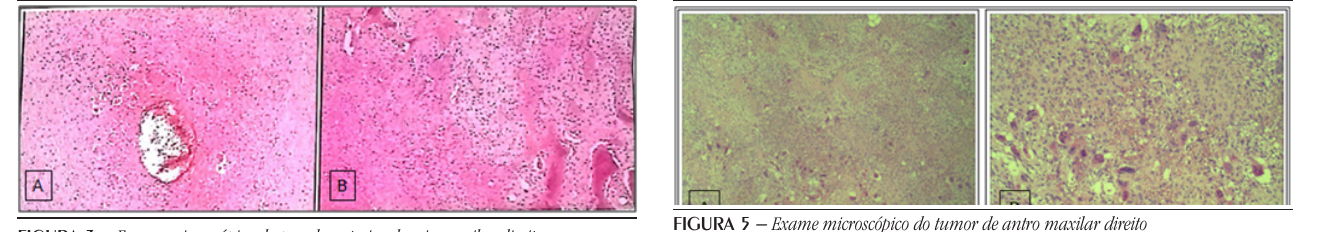
FIGURA 3 – Exame microscópico da parede anterior do seio maxilar direito